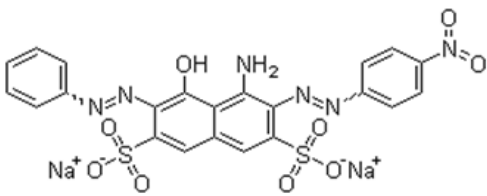
Fig. 1: Developed formula of Naphtol blue black